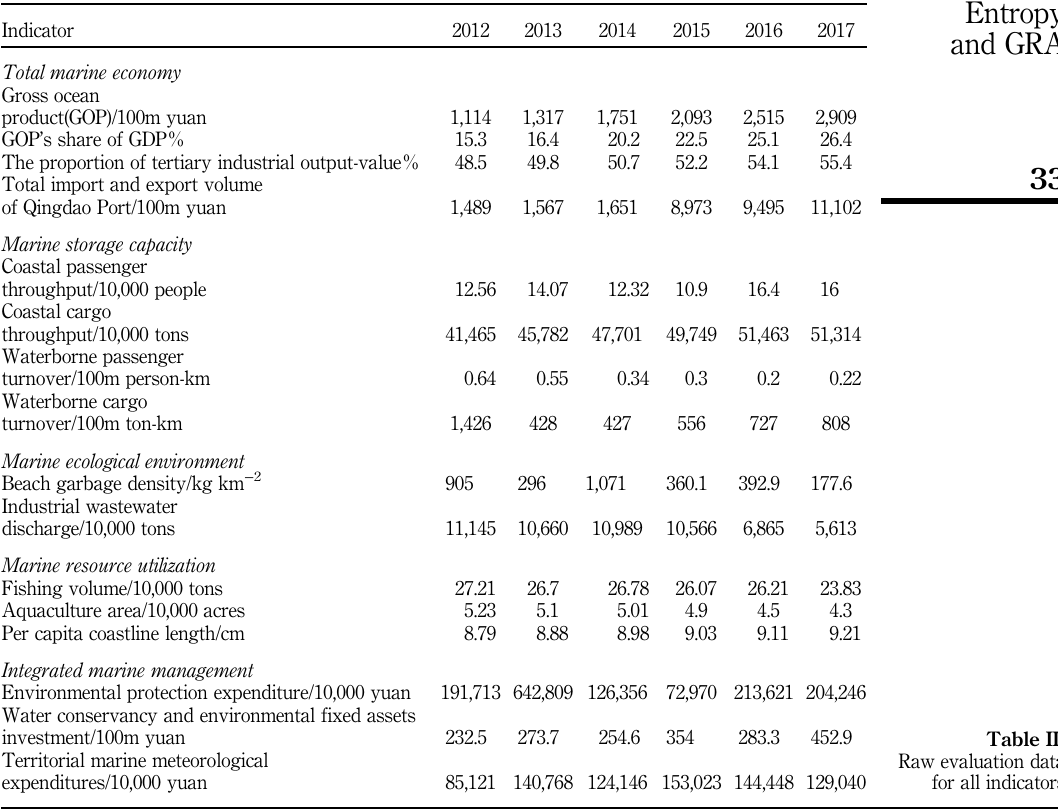
Table II. Raw evaluation